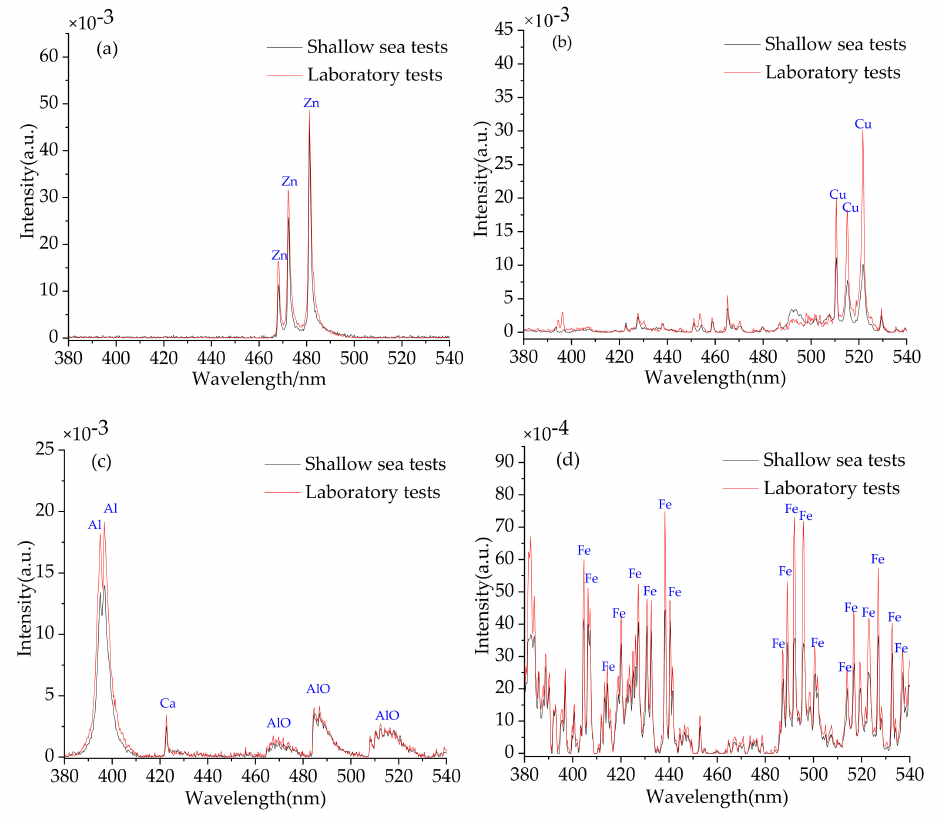
Figure 4. Spectra of pure metal targets of ( a ) Zn, ( b ) Cu, ( c ) Al, ( d ) Fe measured in shallow sea (black line) and in laboratory (red line) for